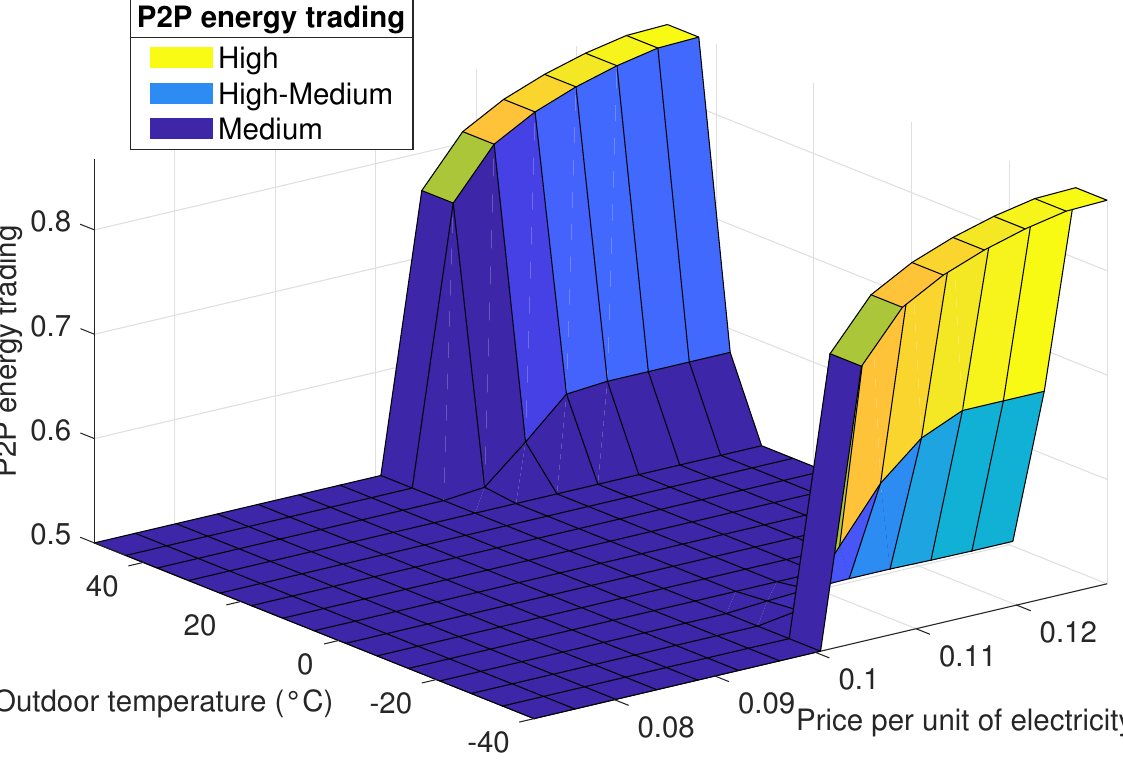
Figure 7. Surface plot of peer-to-peer (P2P) energy trading, with real-time price per unit of electricity on the X-axis and outdoor temperature on the Y-axis. Other parameters are kept constant for simulation purposes to observe the interrelation of real-time price and outdoor temperature input variables with the P2P energy